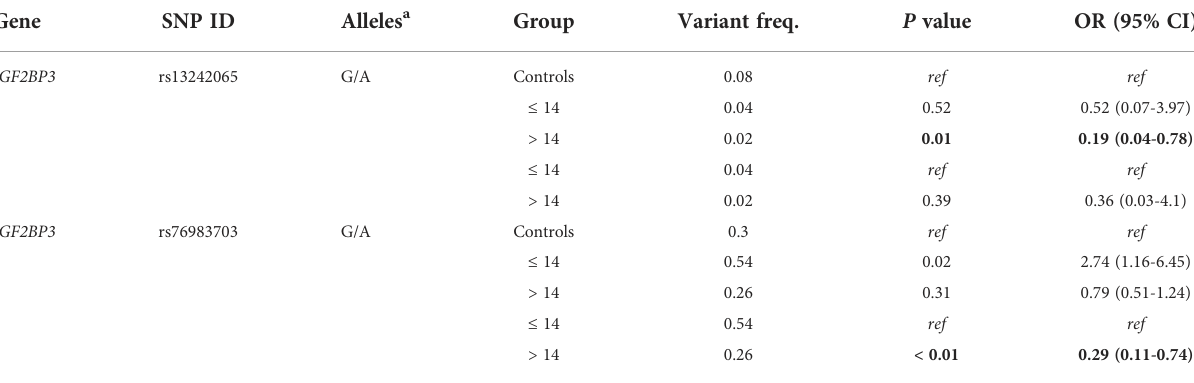
TABLE 4 Association analysis with data strati fi ed by age at EWS diagnosis; only most signi fi cant data are reported. Gene SNP ID Alleles a Group Variant freq. P value OR (95% CI) IGF2BP3 rs13242065 G/A Controls